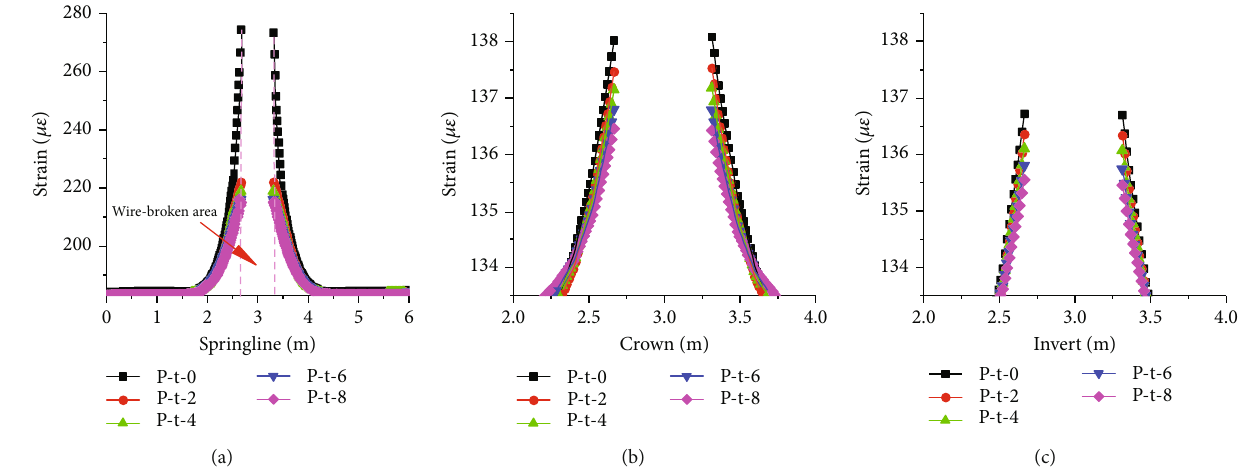
Figure 9: Strain of prestressing wires under combined loads: (a) springline; (b) crown; (c) invert.